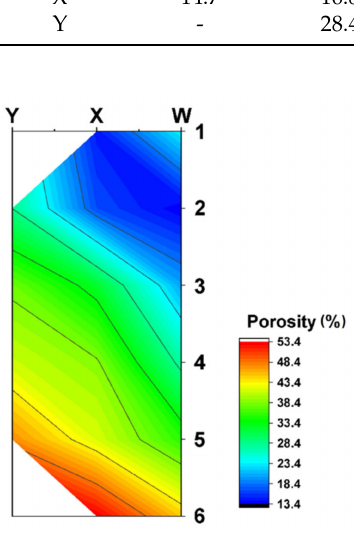
Figure 23. Map of the porosity distribution on the briquette cross-section, respectively for each of the briquette cross-section areas.